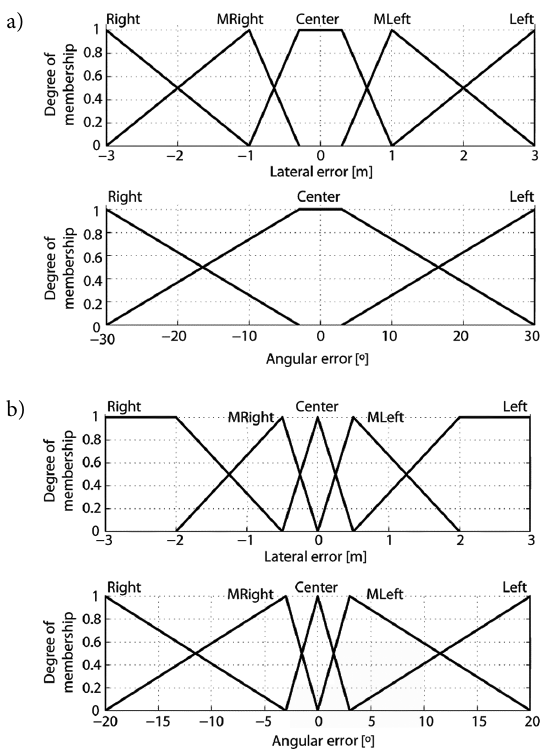
Fig. 6. Membership functions for lateral control: a – low-speed controller; b – high-speed